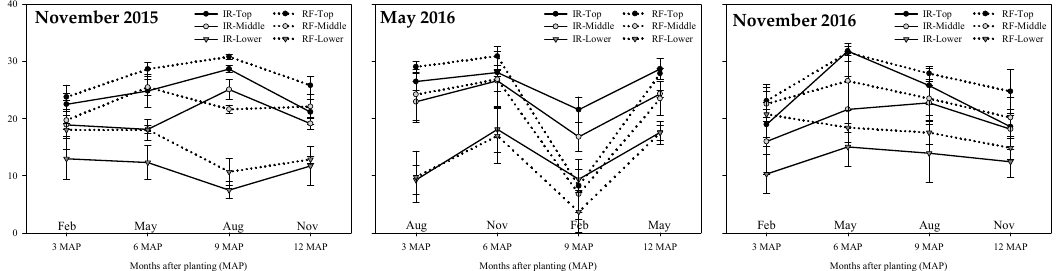
Figure 6. Photosynthesis of top, middle and lower cassava leaves in the canopy at 3, 6, 9, and 12 MAP under irrigated and rainfed conditions when planted in November 2015, and May and November 2016. The bar is standard deviation .